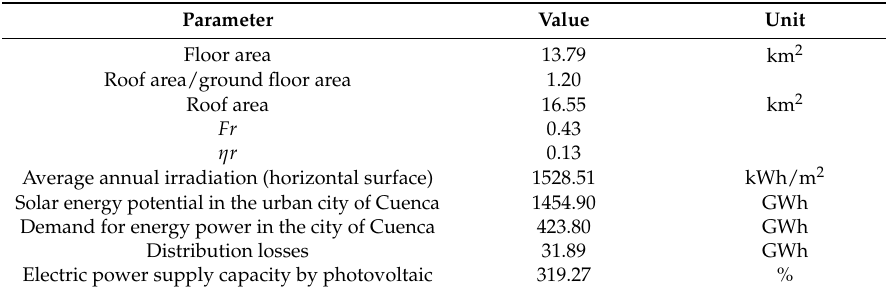
Table 8. The photovoltaic solar potential in the city of Cuenca.